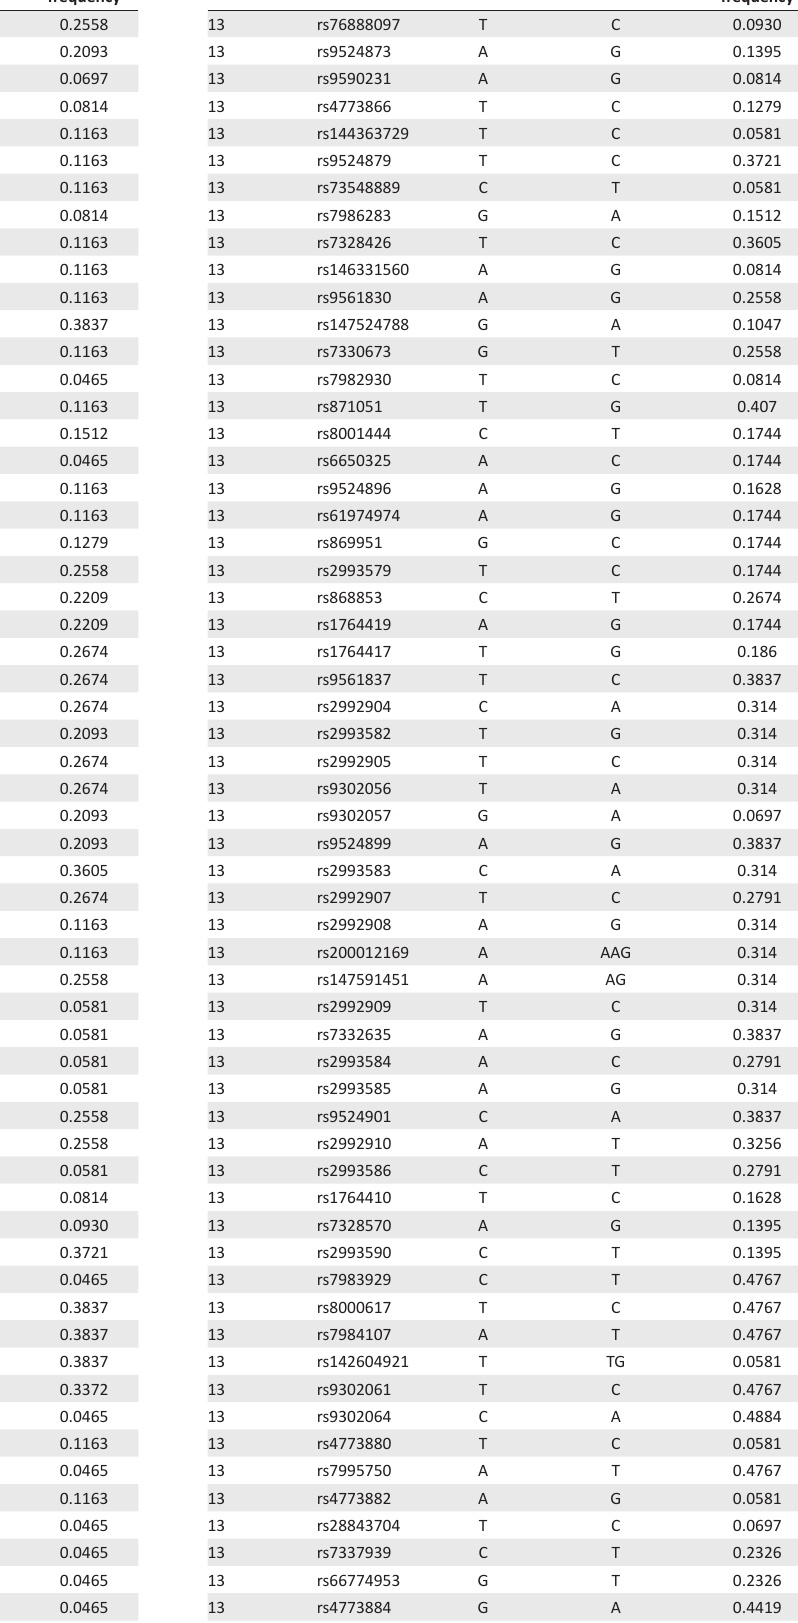
Table 1-A1 (Continues...): Minor allele frequencies for 1846 polymorphisms in 43 black South Africans. Chromosome Polymorphism Minor allele Major allele